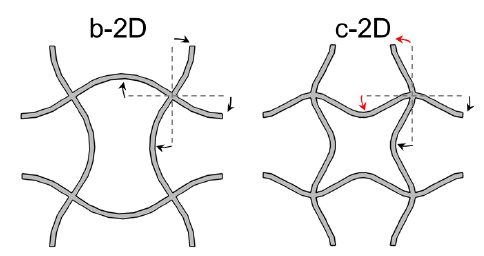
Figure 12. Bending directions of incoming struts for structure b-2D ( a ); and c-2D ( b